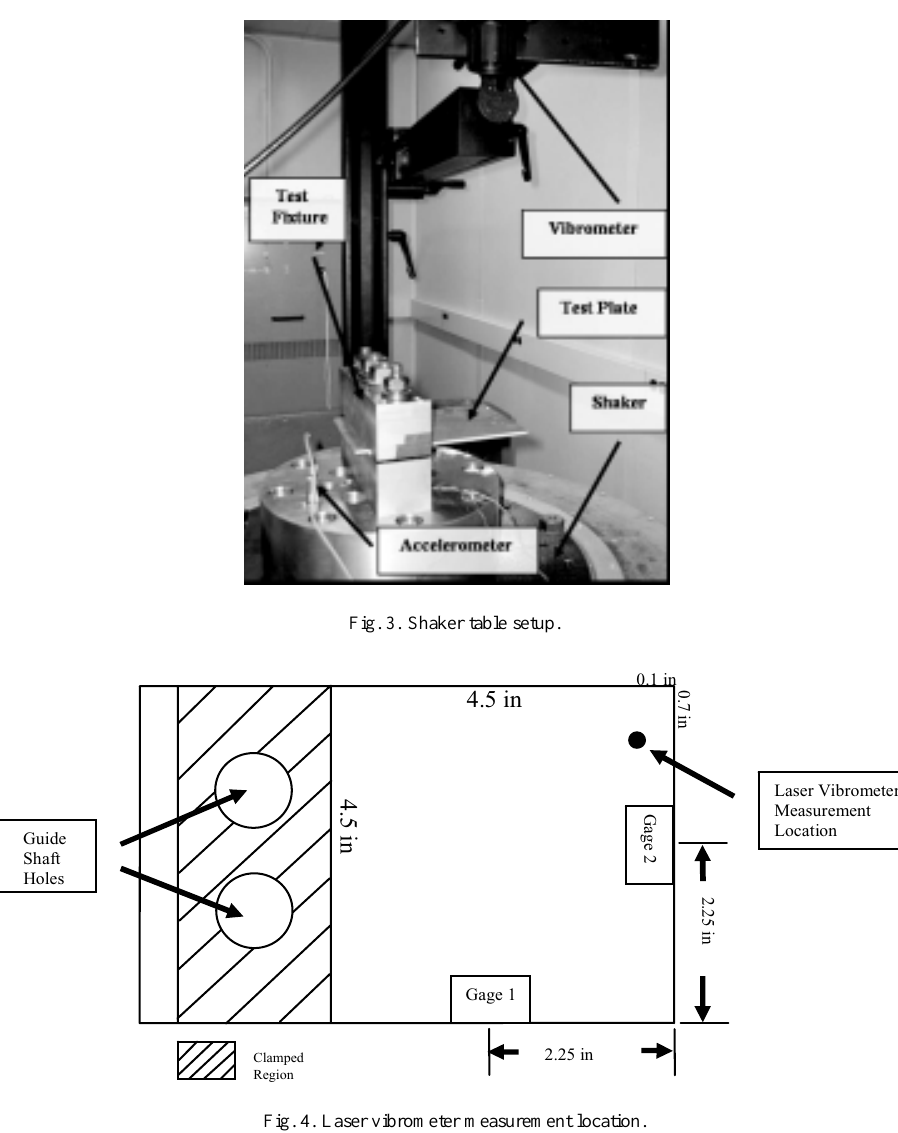
Fig. 4. Laser vibrometer measurement